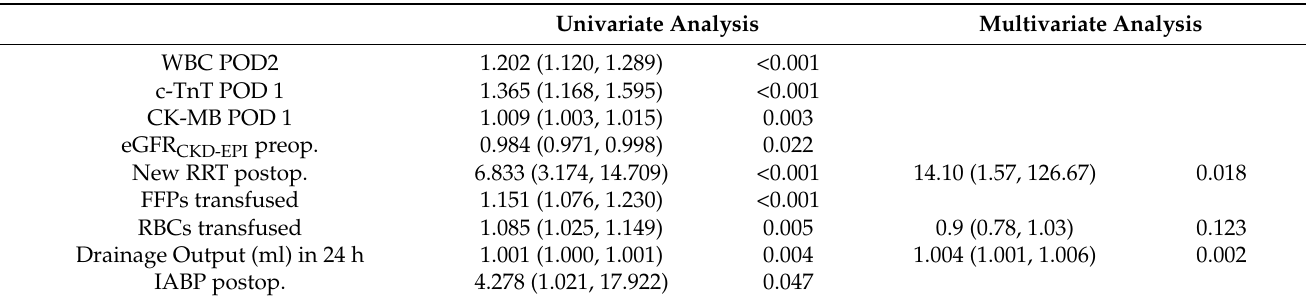
Table 6. Cont. Univariate Analysis Multivariate